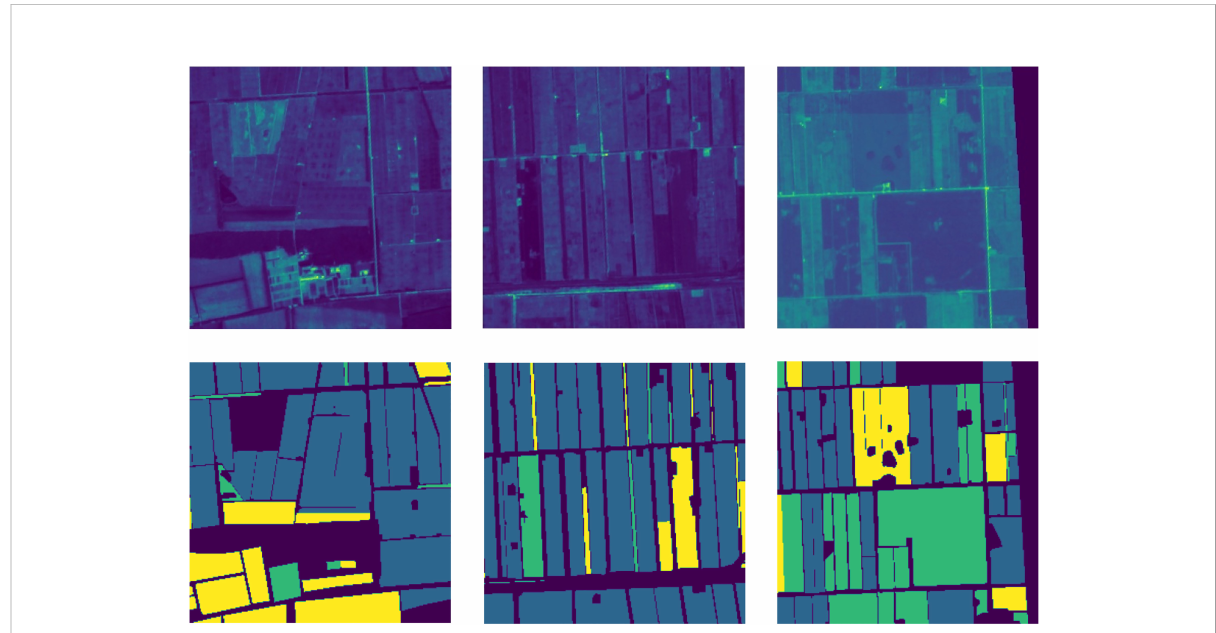
FIGURE 2 The upper part is the image patches, and the lower part is the corresponding ground